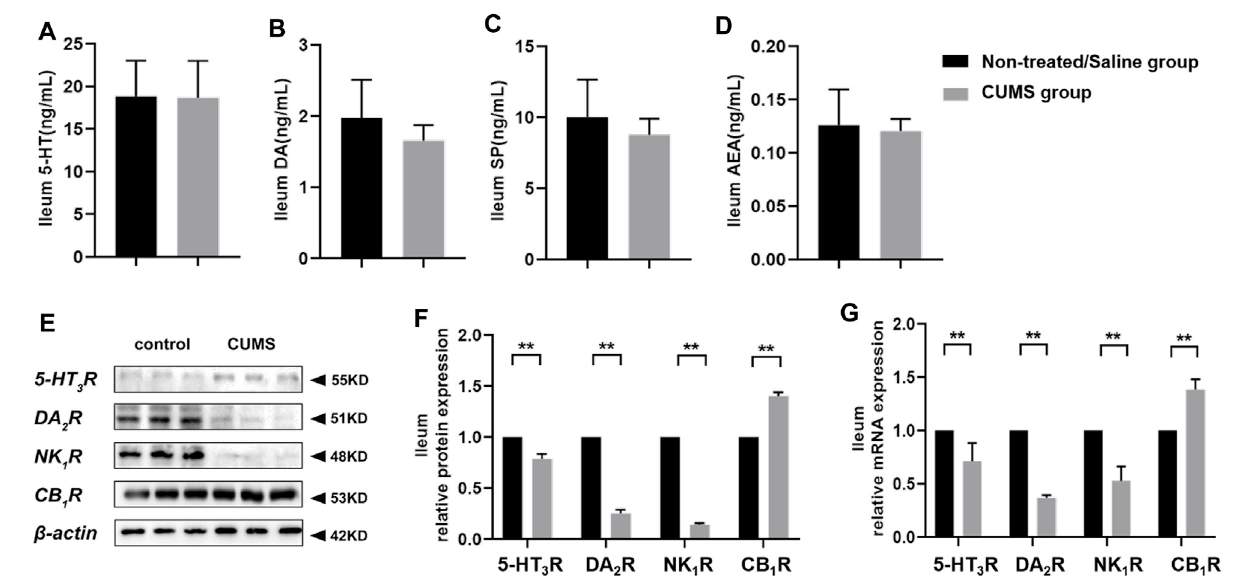
FIGURE 4 | Chronic stress did not alter 5-HT, DA, SP, and AEA levels, downregulated 5-HT 3 R, DA 2 R, and NK 1 R expressions, and upregulated the CB 1 R expression in the peripheral system ( n = 10/group). (A – D) Vomit-related neurotransmitter levels in the ileum. (E,F) Representative Western blotting bands and relative protein expressions of vomit-related receptors in the ileum [normalization: experimental group (target protein/housekeeping protein)/control group (target protein/ housekeepingprotein)]. (G) RelativemRNAexpressionofvomit-relatedreceptorsintheileum[normalization:experimentalgroup(targetgene/housekeepinggene)/ controlgroup(targetgene/housekeepinggene)].Datawereexpressedasmean±SD.** p < 0.01(statisticalcomparisonsbetweenthetwogroupswereperformedusing the two independent sample